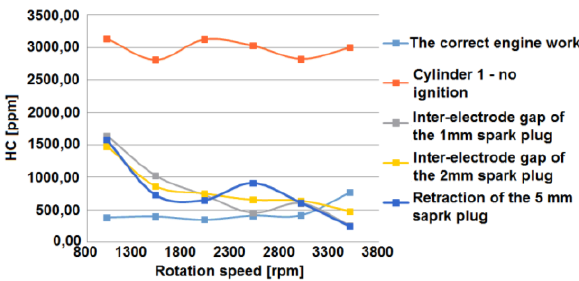
Fig. 11. The hydrocarbon content in the exhaust gas of the BMW M10B18 engine